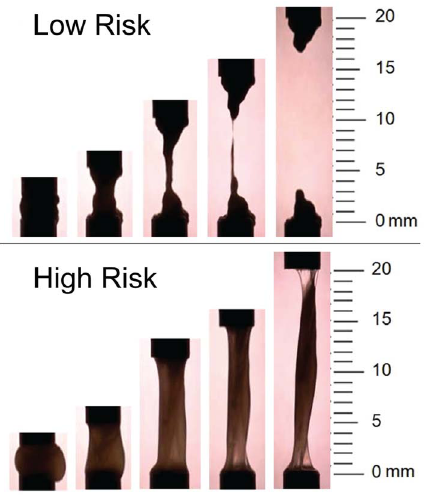
Figure 2. Example time series of spinnbarkeit test at 2, 5, 10, 15, and 20 mm in low-risk and high-risk cervical mucus samples . Almost all high-risk samples could be stretched to at least 20 mm without breaking (exhibiting spinnbarkeit). In contrast, mucus from low-risk patients had an average break length of 13.8 6 2.4 mm.